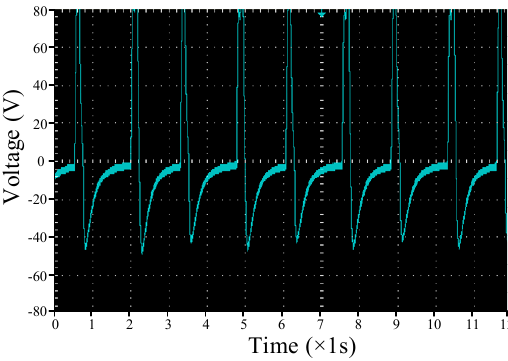
Figure 6. Open-circuit voltage waveform.